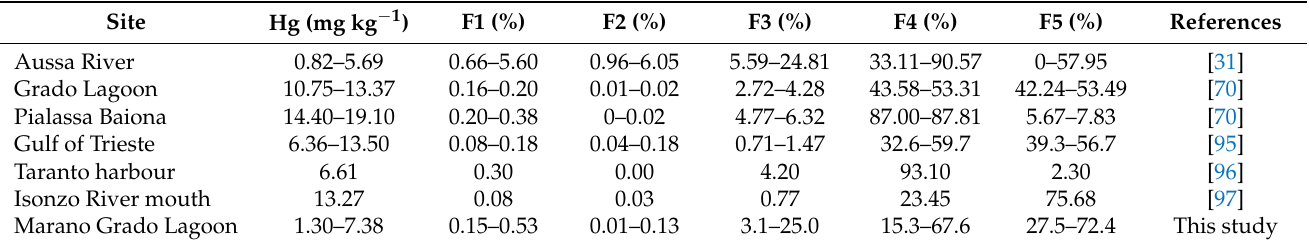
Table 4. Speciation of Hg in the sediment of some coastal sites obtained by Bloom speciation. Mod- ified from Covelli et al. [95].